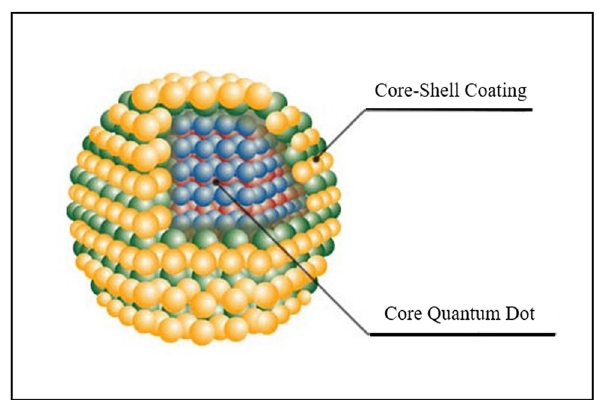
Figure 6: Core QD structure [ 23 ] .